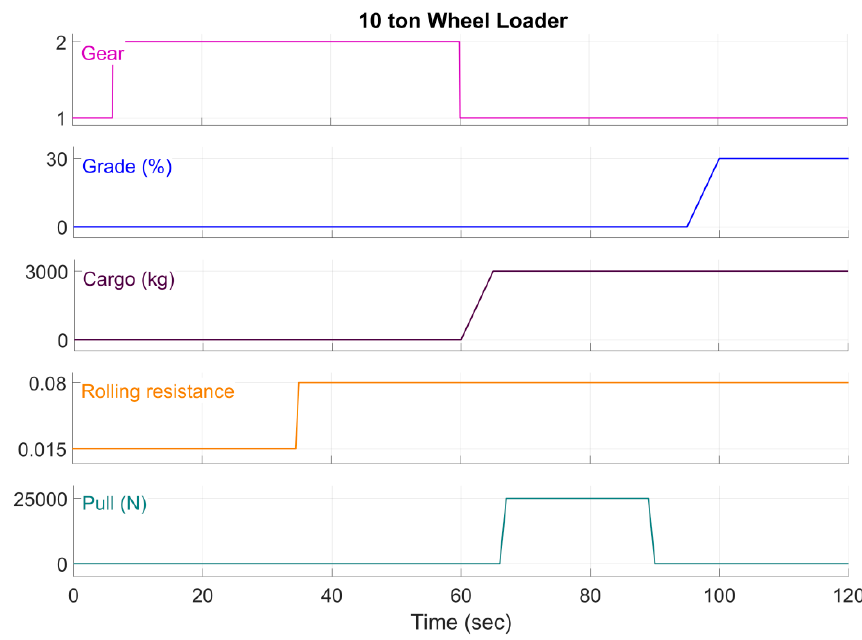
Figure 9. Wheel loader operation condition profiles of the predefined drive cycle.